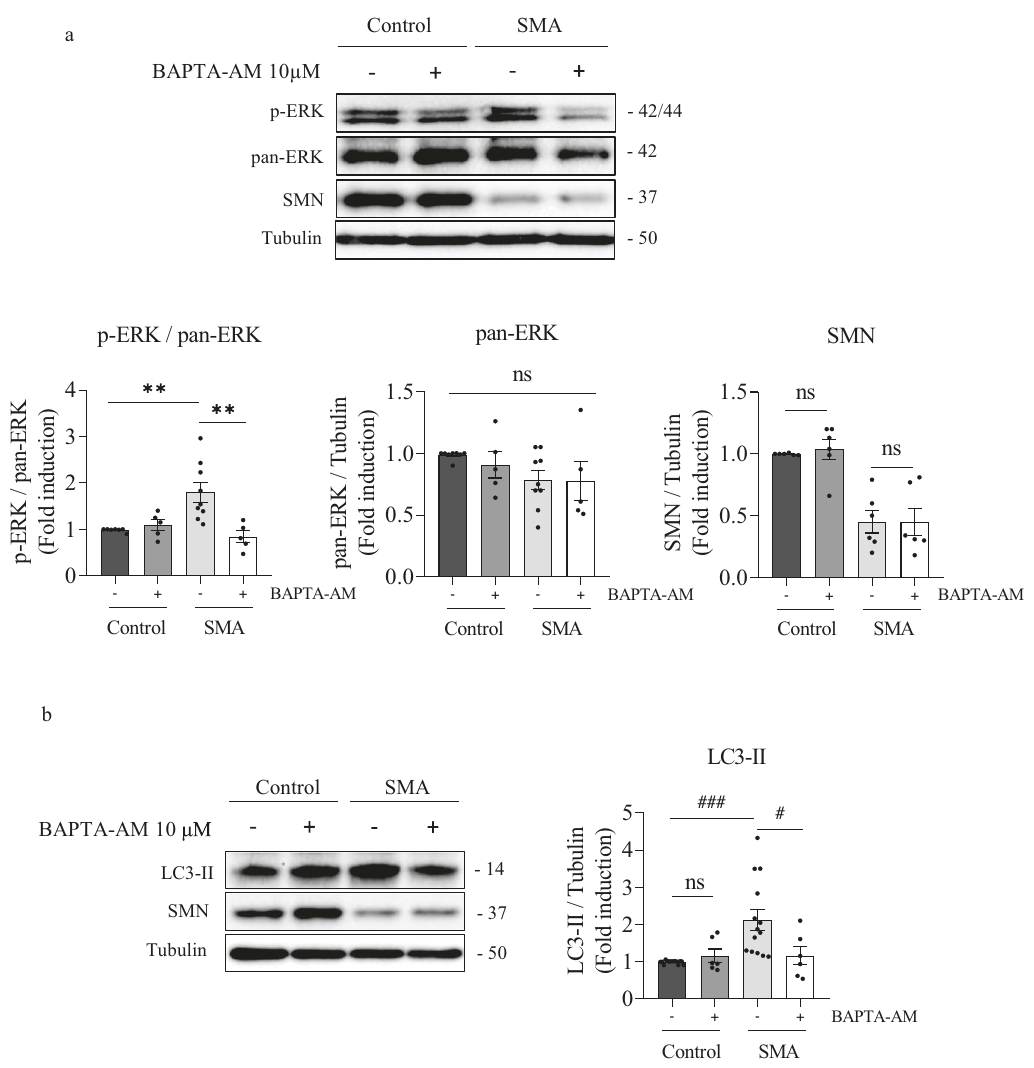
Fig. 6 Calcium chelator BAPTA-AM prevents ERK phosphorylation and reduces LC3-II level in SMA human differentiated MNs. Seven-day differentiated Control and SMA human MN cultures were washed and treated with 10 μ M BAPTA-AM or left untreated. At 24 h, protein extracts were obtained and submitted to western blot analysis using anti-p-ERK ( a ), anti-LC3 ( b ), or anti-SMN ( a , b ) antibodies. Membranes were stripped and reprobed with anti-pan-ERK antibody or with anti- α -tubulin antibody. Graphs represent the expression of p-ERK vs pan-ERK ( a ), or ERK ( a ) or SMN ( a ) or LC3-II ( b ) vs α -tubulin, corresponding to the quanti fi cation of at least 3 independent iPSCs differentiation cycles ± SEM. Symbols indicate differences using one-way ANOVA with Tukey ’ s multiple comparisons post-test (** p < 0.01) or Kruskal-Wallis with Dunn ’ s multiple comparisons post-test ( # p < 0.05; ### p < 0.001); (ns no signi fi cant differences p > 0.05). Statistical analysis reaction. The assays were performed in a CFX96 Real-Time System (Bio- All experiments were performed at least three independent times (from Rad, Hercules, CA, USA) using iTaq ™ Universal SYBR ® Green One-Step three separate mouse offspring for primary MN cultures or three Kit from Bio-Rad. For CD1 experiments, Real-Time was performed using separate iPSCs differentiation cycles). Values were expressed as mean ± mouse Smn -speci fi c primers: Smn exon 1-forward (5 ′ -GATGATTCTGA- estimated standard error of the mean (SEM). Statistical analysis was CATTTGGGATG-3 ′ ) and Smn Exon 2-reverse (5 ′ -TGGCTTATCTGGAGTTT- performed using GraphPad Prism, version 9.4.1 (GraphPad Software Inc, CAGAA-3 ′ ) and speci fi c primers of mouse glyceraldehyde-3-phosphate San Diego, CA, USA). Normality of the data was tested with Shapiro-Wilk dehydrogenase ( Gapdh ): Forward (5 ′ -TGCACCACCAACTGCTTAG-3 ′ ) and test. If the data distribution was normal, differences between two reverse (5 ′ -GGATGCAGGGATGATGTTC-3 ′ ) as internal control. For groups were assessed by two-tailed Student t- test, and differences human differentiated MNs, Real-Time was performed using human SMN -speci fi c primers: SMN exon 6-forward (5 ′ -CCGCCACCCCCTCC- between more than two groups one-way ANOVA with Tukey ’ s multiple comparisons test was used. If the data was not following a normal CATCTCT-3 ′ ) and SMN Exon 8-reverse (5 ′ - CATCTCCTGAGACA- distribution, the non-parametric two-tailed Mann-Whitney test was GAGCTGA-3 ′ ) and speci fi c primers of human glyceraldehyde-3- applied to compare differences between two groups, and for more than two groups the non-parametric Kruskal-Wallis with Dunn ’ s multiple comparisons test was performed. Values were considered signi fi cant when p < 0.05. Statistical signi fi cance is shown with “ * ” when a parametric test was applied and with “ # ” when a non-parametric test Each sample was measured in triplicate; relative fold change gene was applied. expression levels were calculated with the formula 2^ − ( ΔΔ Cq).